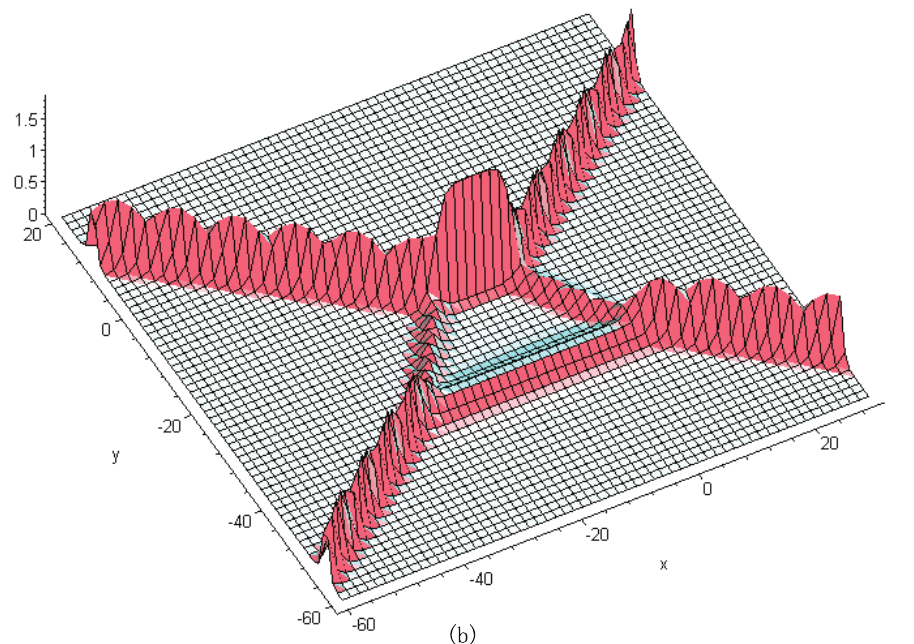
Figure 1. The snapshot of two soliton interaction at the time t = 6. ( a ). The arbitrary function in Equation (3) for v is taken as Equation (12) for l 1 = 1, l 2 = 4, k = 1, at t = 6. ( b ). Under the condition Equation (13) for l 1 = 1, l 2 = − 2, k = 1.4, ξ 0 = 1, ξ 1 = 2, ξ 2 = 3,